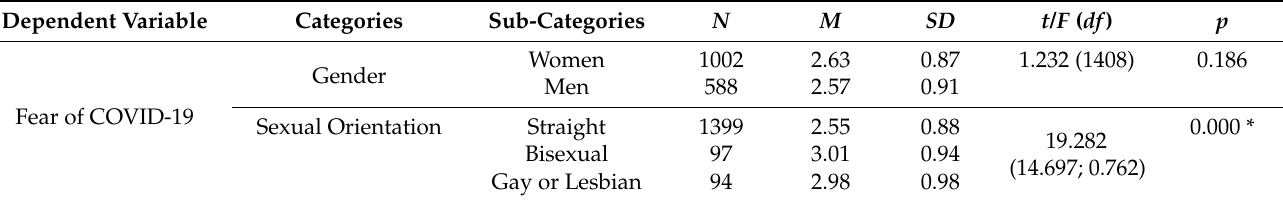
Table 6. Differences in the Negative Impact of COVID-19 by Gender and Sexual Orientations.